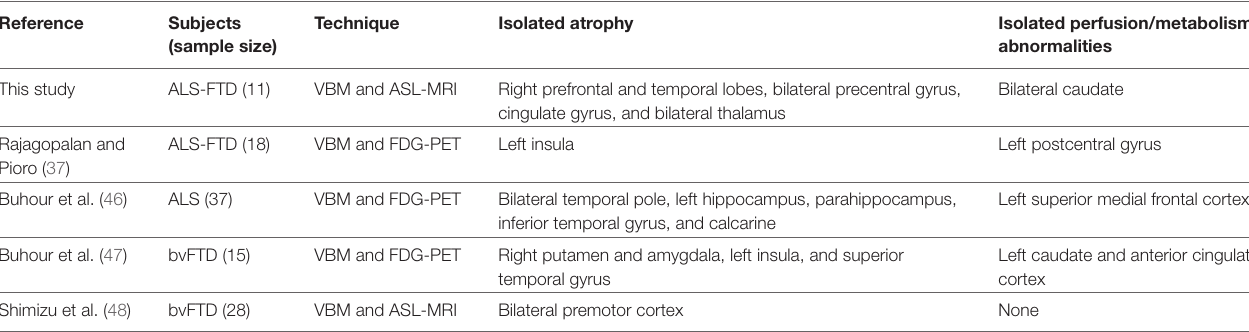
TaBle 2 | Summary of studies comparing perfusion/metabolism and structural changes in patients on the ALS/FTD